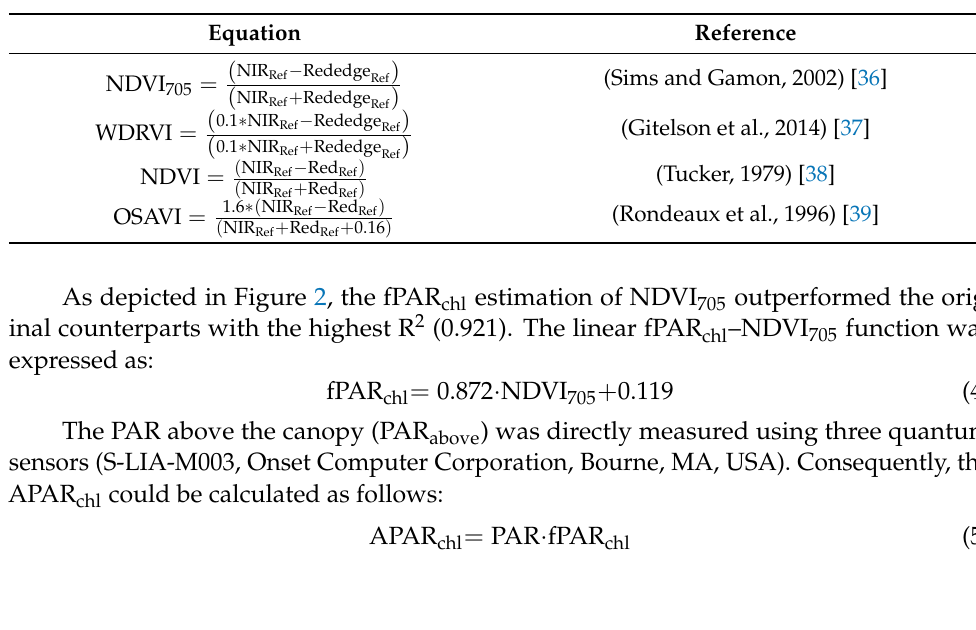
Table 4. Mathematical formulations and references for the